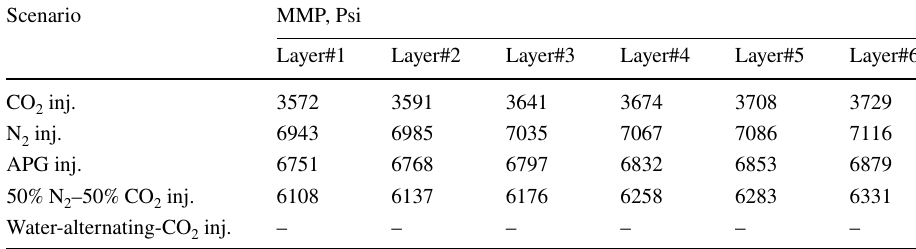
Table 4 MMP variations with reservoir depth for injection of different gases into the reservoir